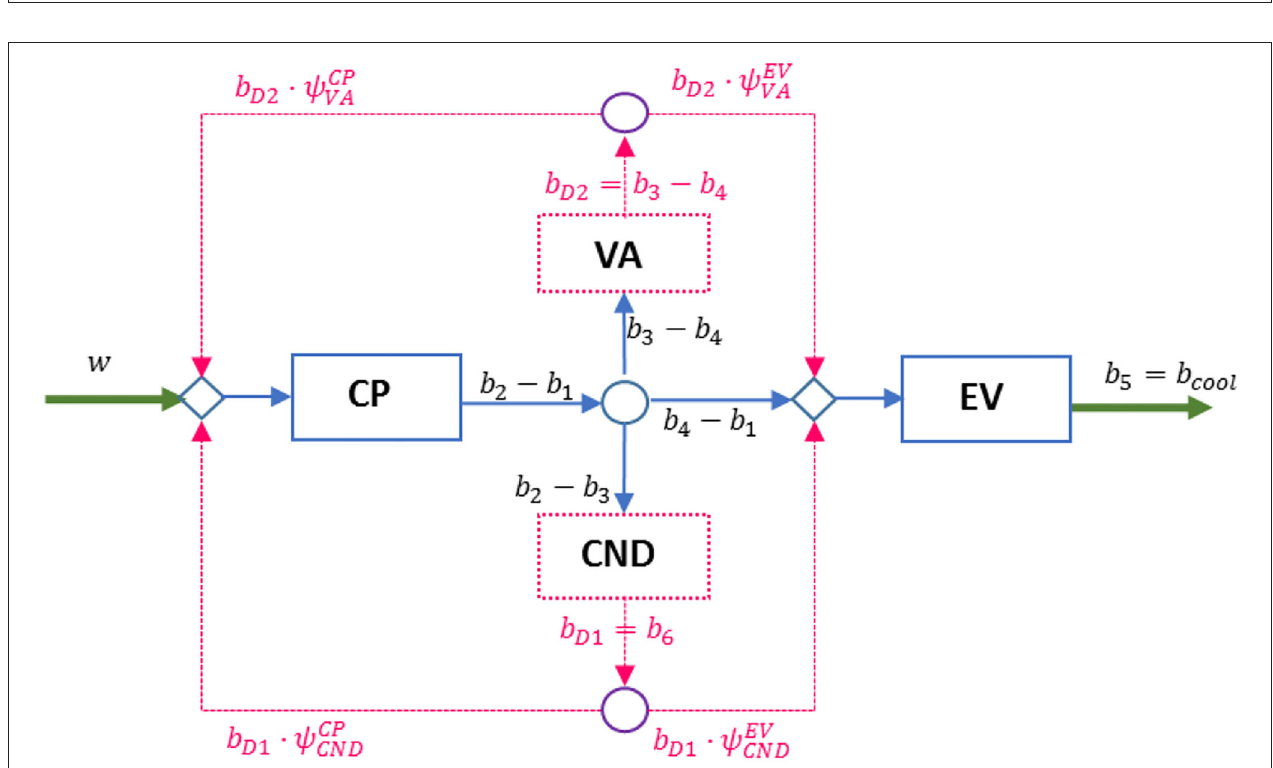
FIGURE 3 | Condenser and throttling valve as dissipative